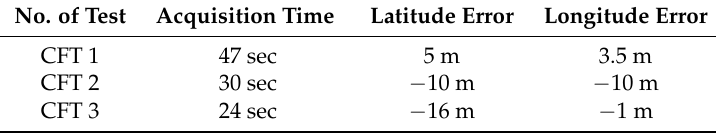
Table 4. Batch processing-based TRN acquisition position error of the captive flight tests.